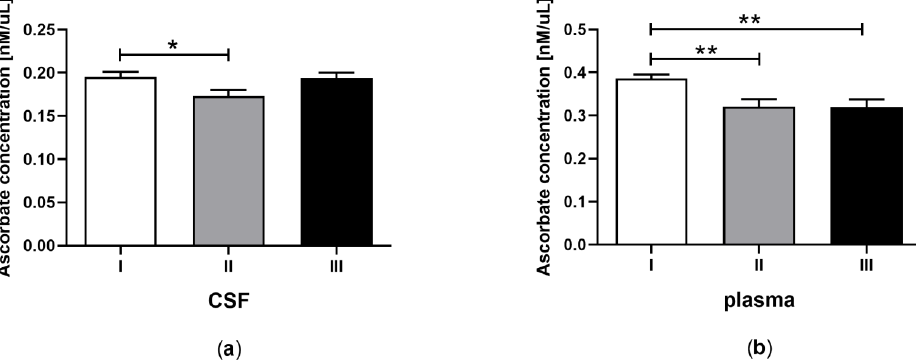
Figure 3. Total ascorbate concentration in CSF (a) and plasma (b) of the patients in MCS before (white bars) and after first (grey bars) and second (black bars) transplantation of BM-MSC. The statistical analysis was determined by a one-way ANOVA followed by Tukey’s multiple comparison test ( p < 0.05). Asterisks indicate differences in the antioxidant capacity between examining groups (* p < 0.05; ** p < 0.001).